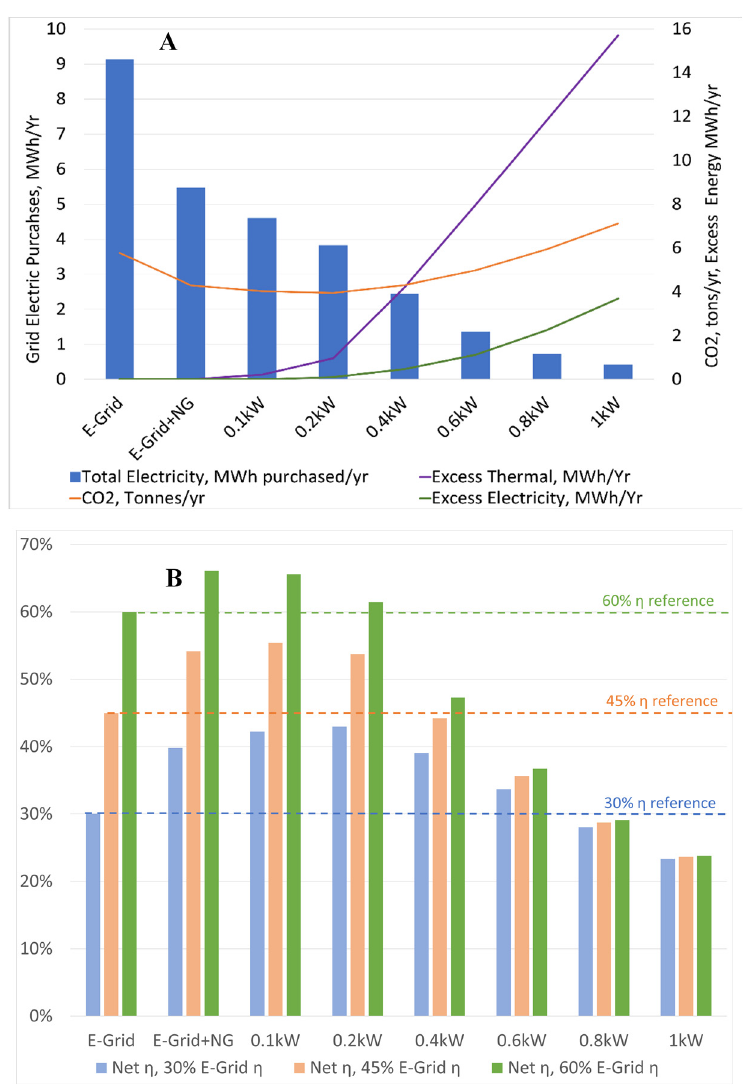
Figure 3. Influence of generator power scale on E-Grid demand, total carbon dioxide emissions, excess electrical and thermal energy produced, and net combined efficiency of the residential energy system. ( A ) CO 2 , E-Grid purchases vs. different configurations. ( B ) Total energy efficiency vs. cogeneration system power rating. No PV or thermal energy storage in the cogeneration system configuration.